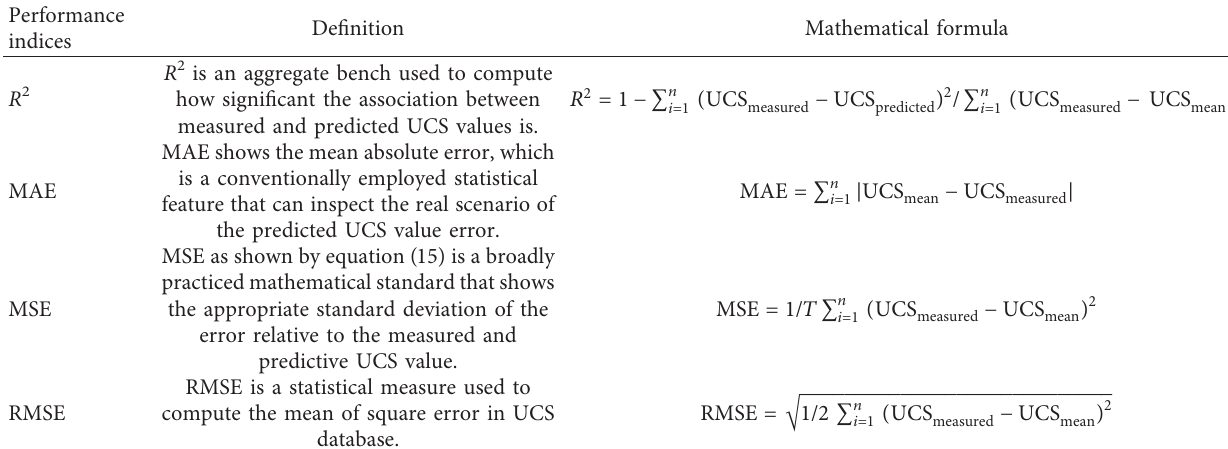
Table 8: Performance indices employed in this work.